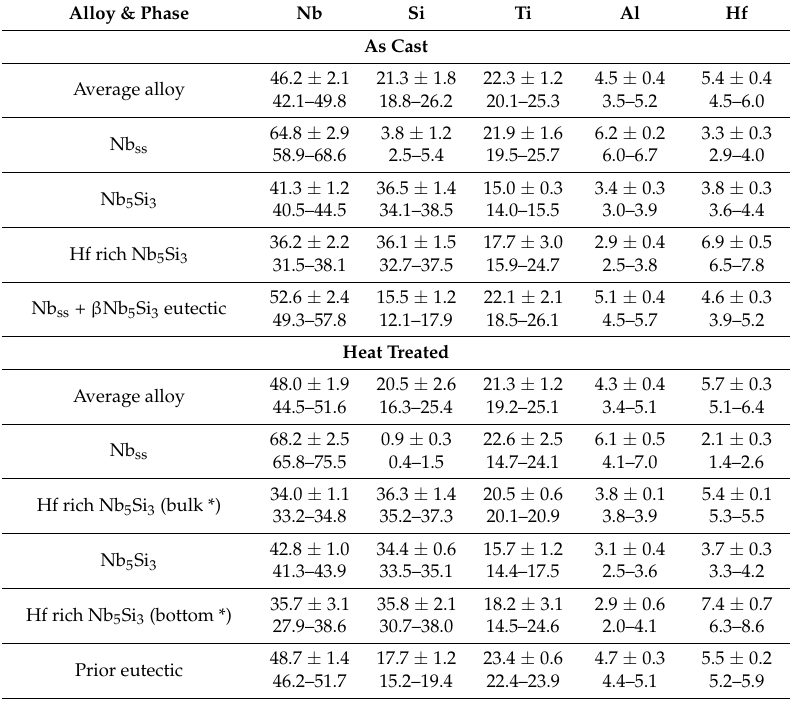
Table 1. SEM-EDS data (at.%) for the as cast and heat treated alloy Nb-24Ti-18Si-5Al-5Hf (average value, standard deviation, minimum and maximum analysis values).